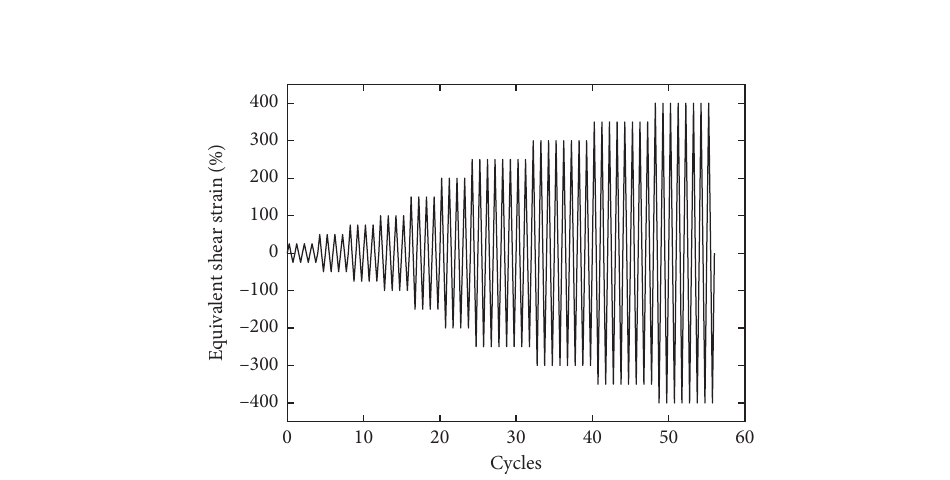
Figure 4: Cycle loading testing protocol.